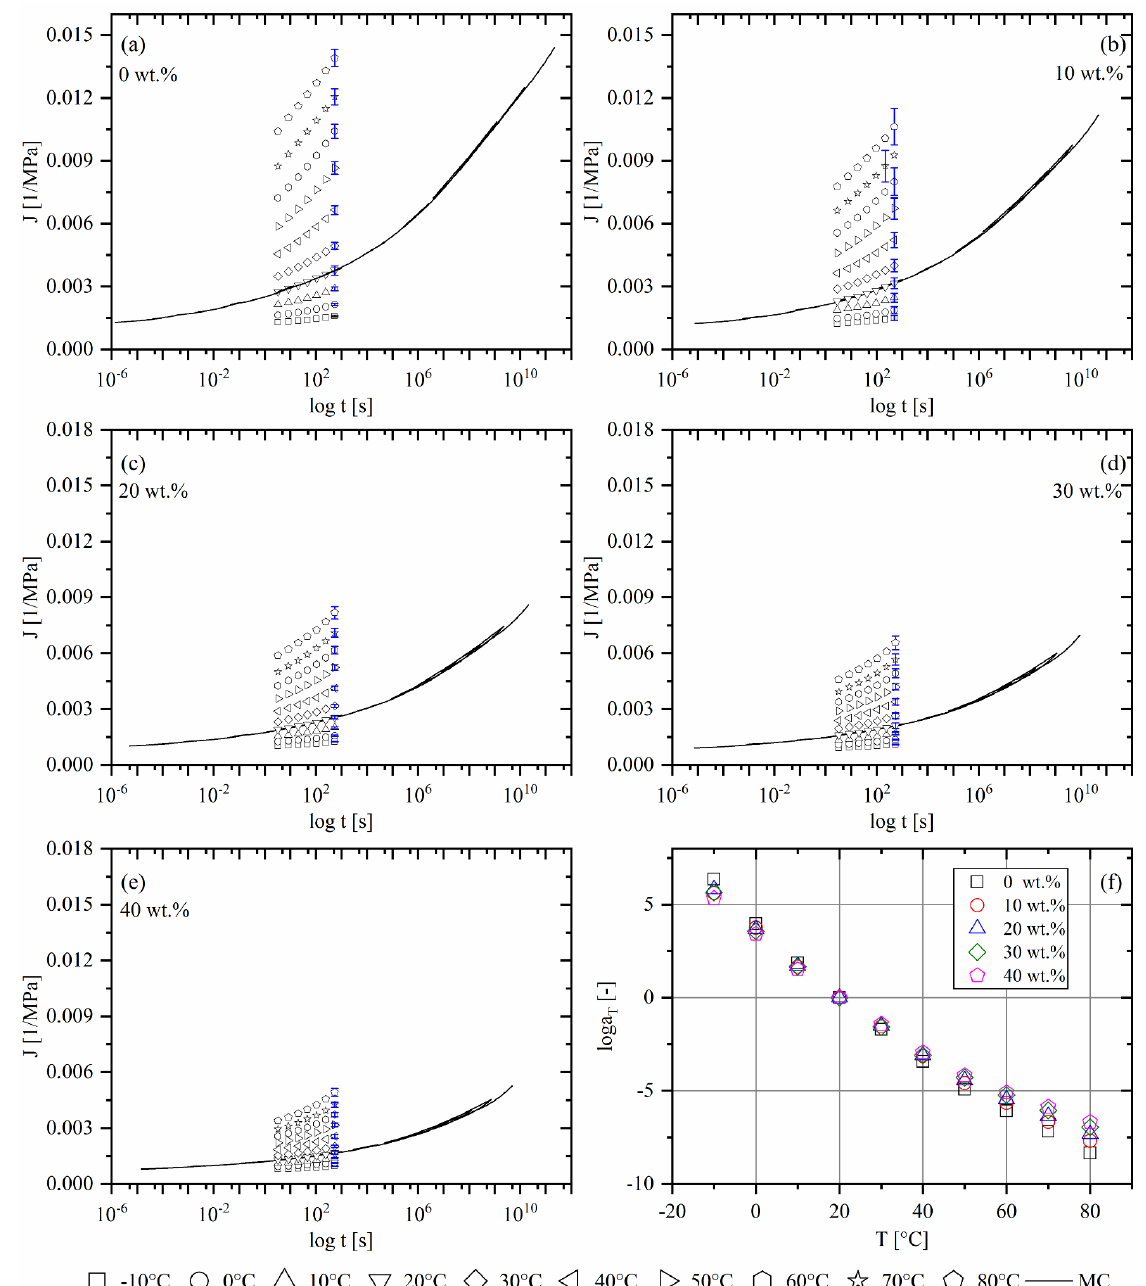
Figure A2. ( a – e ) Individual segments with corresponding mastercurves at 𝑇 𝑟𝑒𝑓 = 20 °C for different wood fiber concentrations and ( f ) temperature shift factors. All diagrams show composites with RPP matrix.